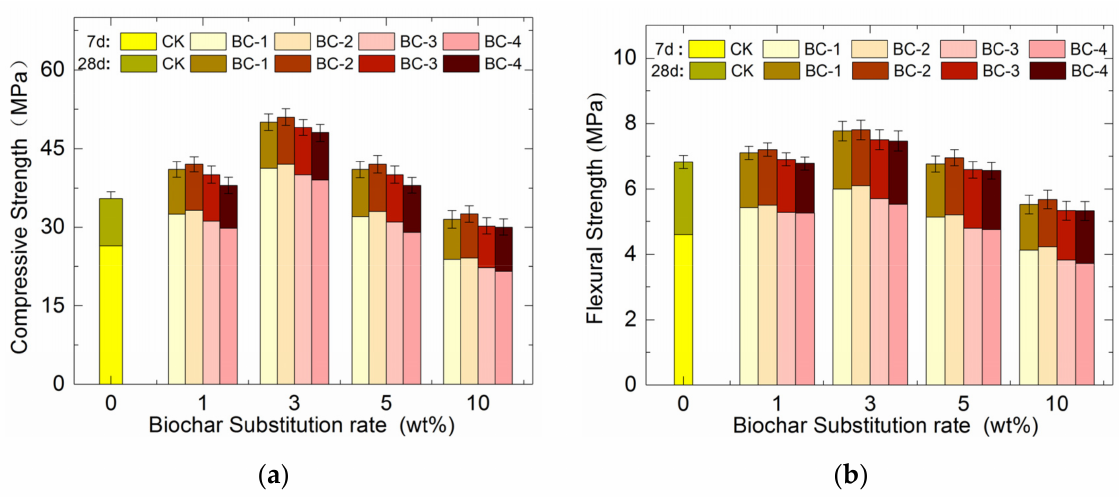
Figure 7. Mechanical strength of concrete with different fineness levels and biochar dosages: ( a ) compres- sive strength; ( b ) flexural